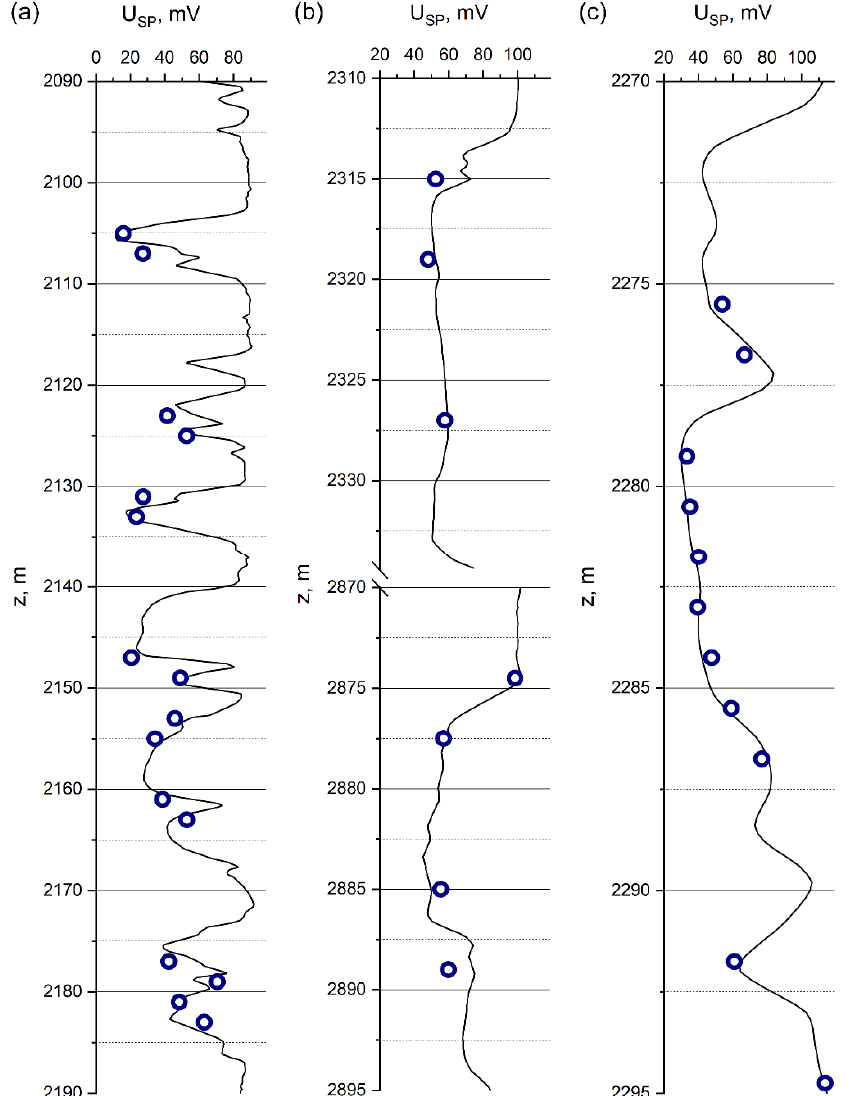
Figure 10. Comparative analysis of synthetic (circles) and practical (line) SP logging data for differ- ent in-depth oil-bearing formations of the Lower Cretaceous deposits of the Achimov formation, penetrated by wells of the fields of Latitudinal Ob Region of Western Siberia. For well A layers BS 9 - BS 13 are considered ( a ); for well B-AS 10 , BS 16 -BS 20 ( b ), for well C-AS 10 ( c